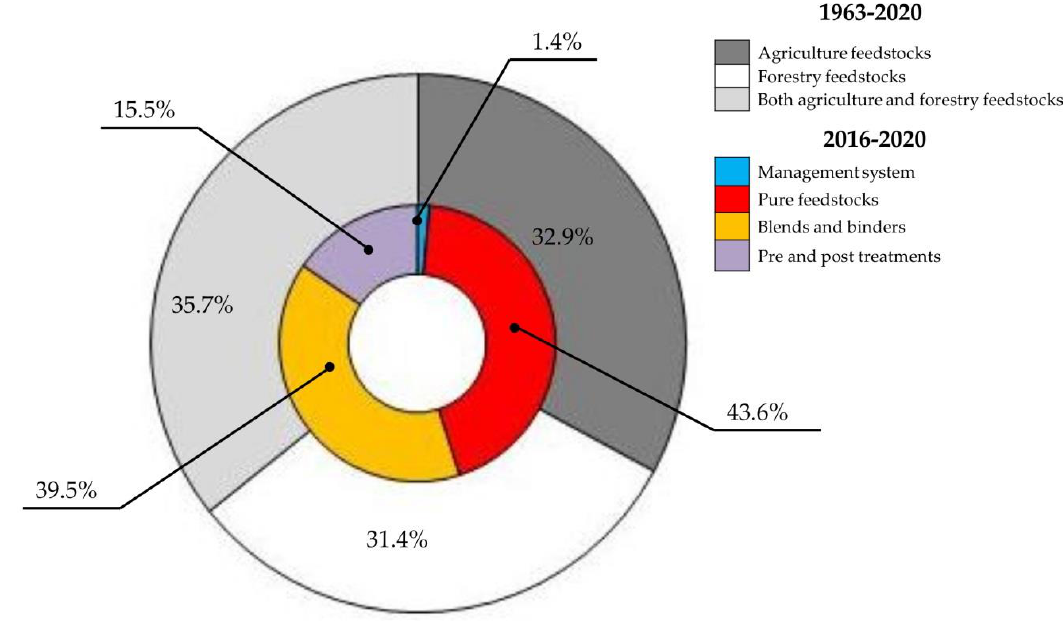
Figure 2. Percentages of the various identified main topics in relation to the total number of analyzed papers.